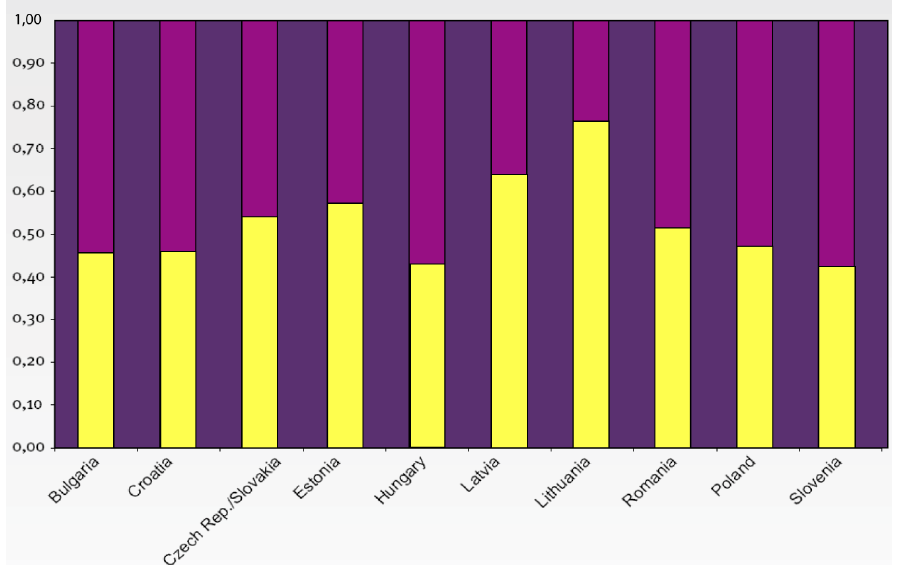
Figure 1. Reduction in Railway Employment Levels in the New EU-member States over 1990-2004. Source: The publication of the Community of European Railway and Infrastructure Companies (CER) in 2004, “The Railways in an Enlarged Europe. Perspectives for the Sector in the New Member Sates of the European Union” page